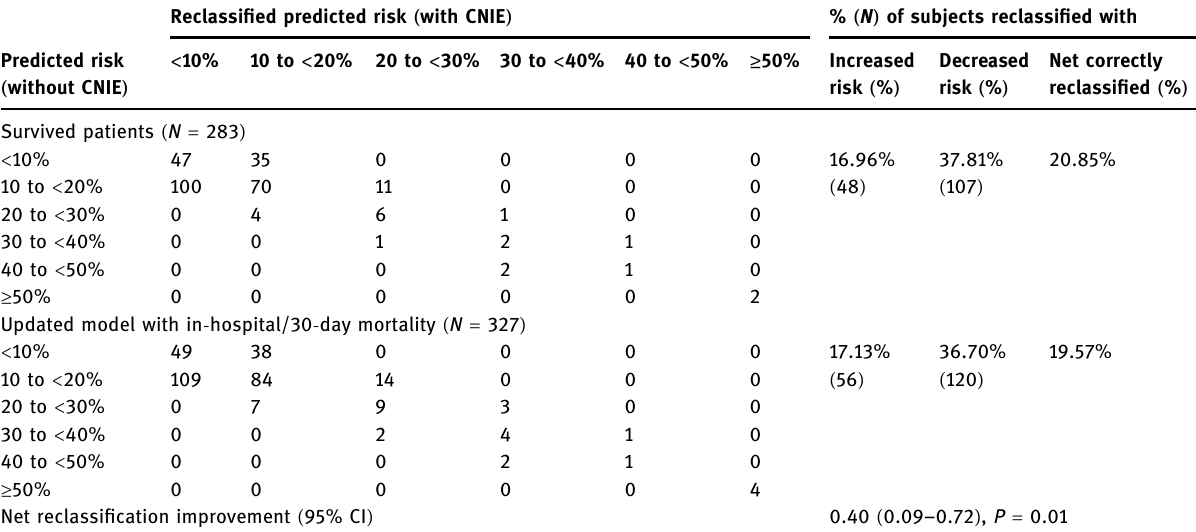
Table 4: Reclassi fi cation table comparing early mortality risk models without and with CNIE Reclassi fi ed predicted risk ( with CNIE )